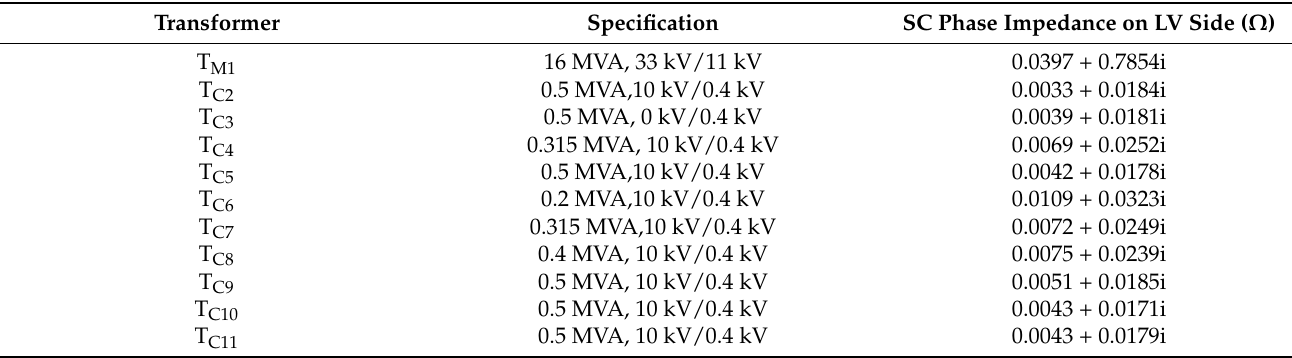
Table A2. Transformer